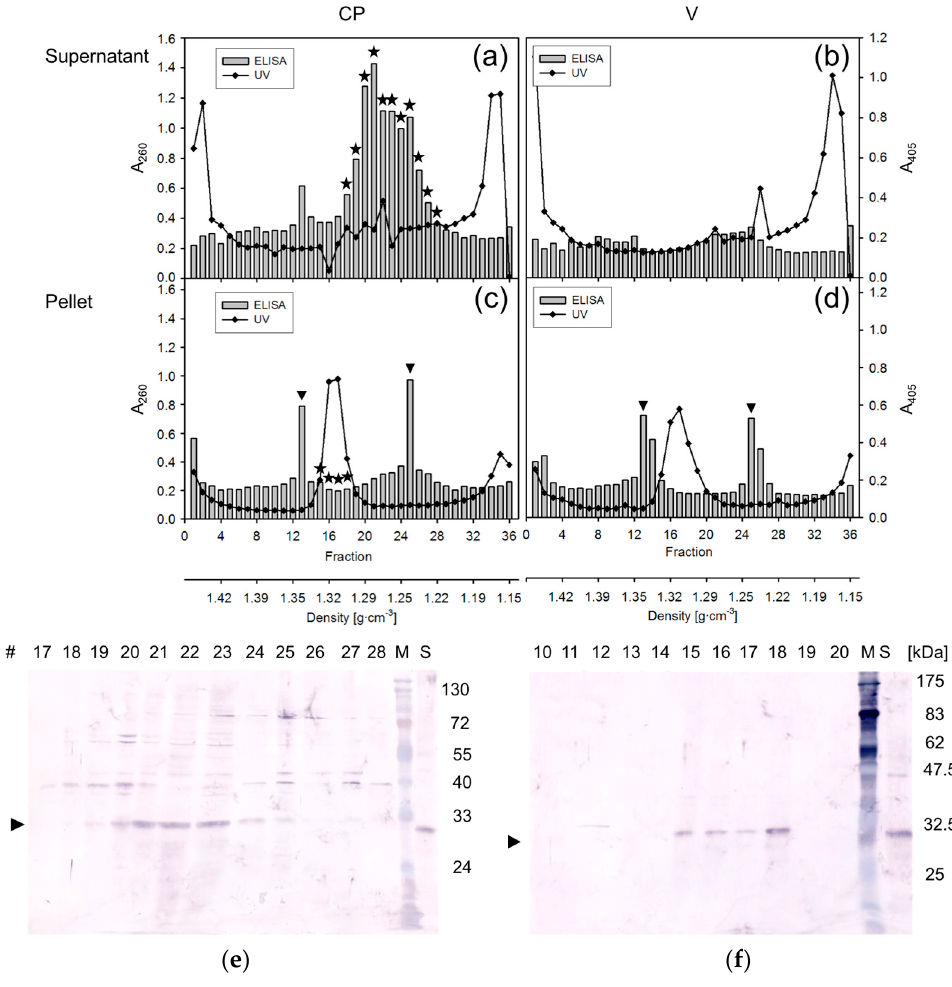
Figure 2. Differentiation of free and DNA-bound CP. Extract supernatants ( a , b ) and pellets ( c , d ) after isopycnic centrifugation from cells with pESP1-pREP2:AV1 ( a , c , CP) or pESP1-pREP2 ( b , d , V) induced for protein expression and harvested 9 hpi. Profiles for UV absorption (line, A 260 ; left y -axis) and CP-specific ELISA reads (columns, A 405 ; right y -axis) are superimposed, and densities are plotted onto a second x -axis. Unspecific signals are marked by arrowheads, CP signals confirmed by Western blots (asterisks) on top of the columns; ( e , f ) selected fractions analyzed by SDS-PAGE/Western blotting as described in Figure 1.